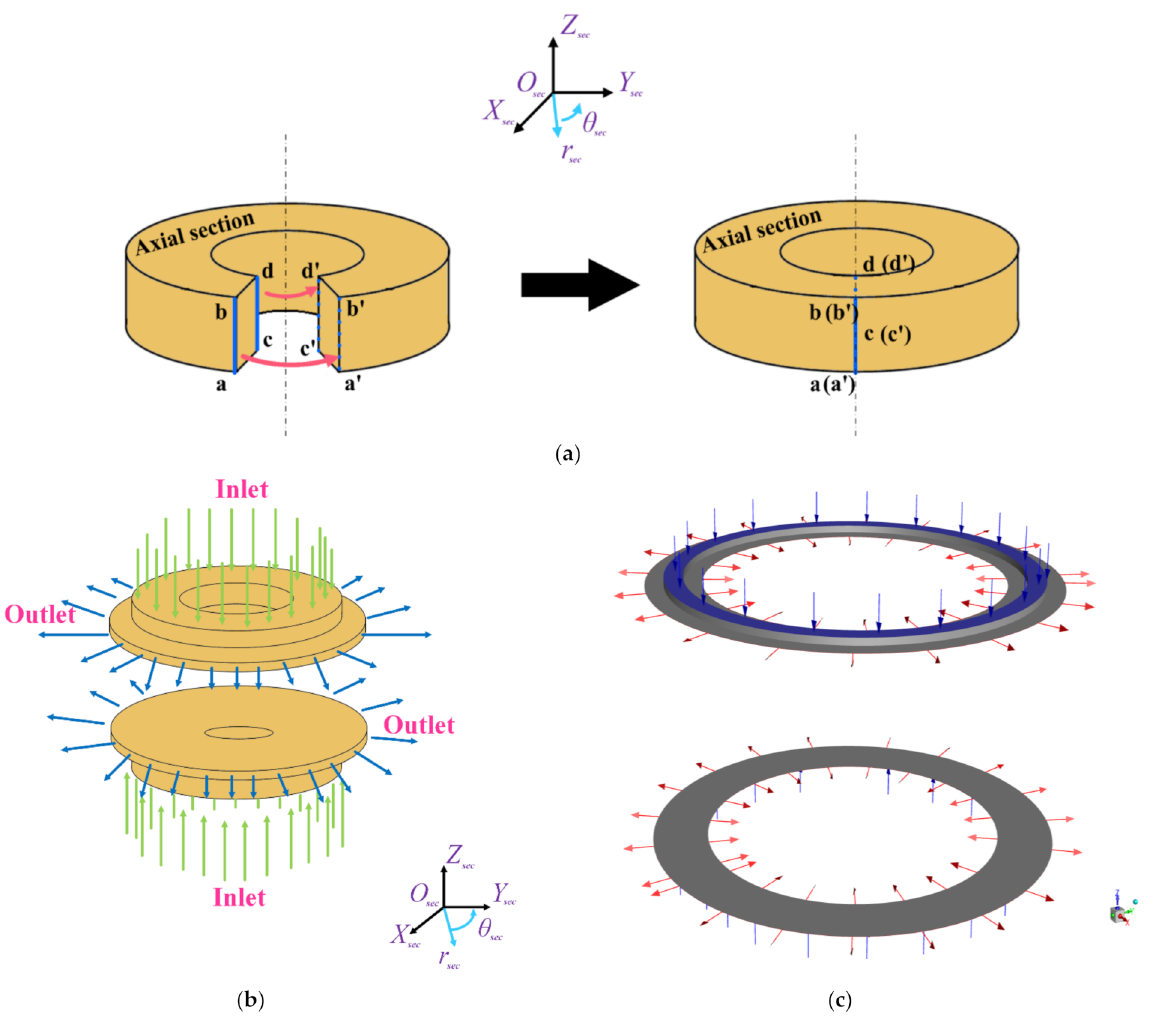
Figure 2. Fluid domain of a fluid lubricated screw-nut pair. ( a ) Establishment method of CFD model. ( b ) Schematic diagram of computational domain. ( c ) CFD model in